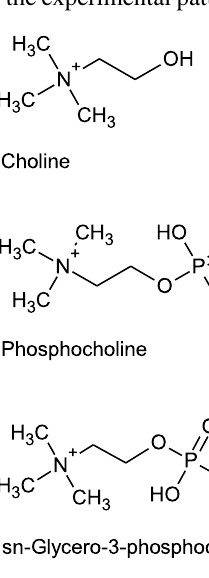
Fig. 2. Chemical structure of Choline (Cho), Phosphocholine (PCho) and sn-Glycero-3-phosphocholine